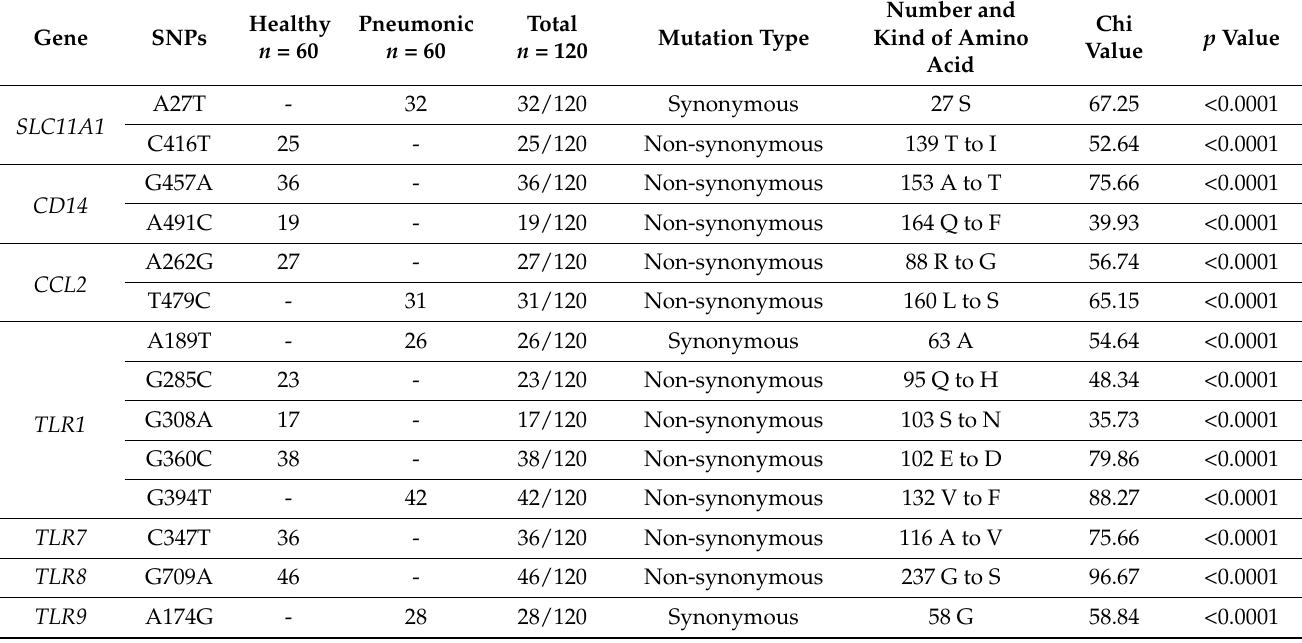
Table 1. Healthy and pneumonic Baladi goats’ SNP dissemination and type of mutation for the genes in